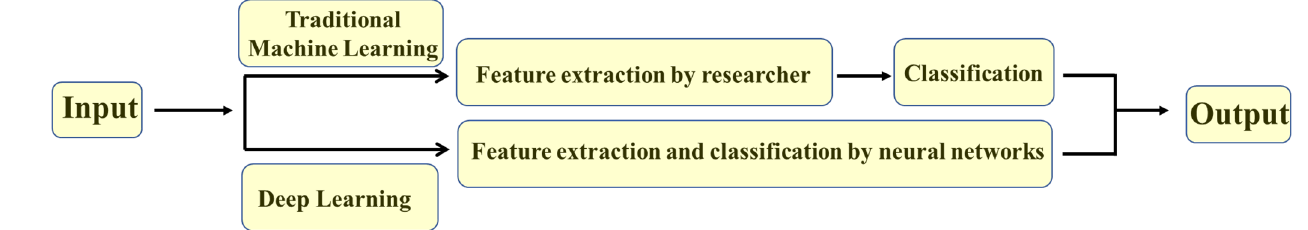
Figure 2. Schematic representation showing the main difference between traditional machine and deep learning approaches.